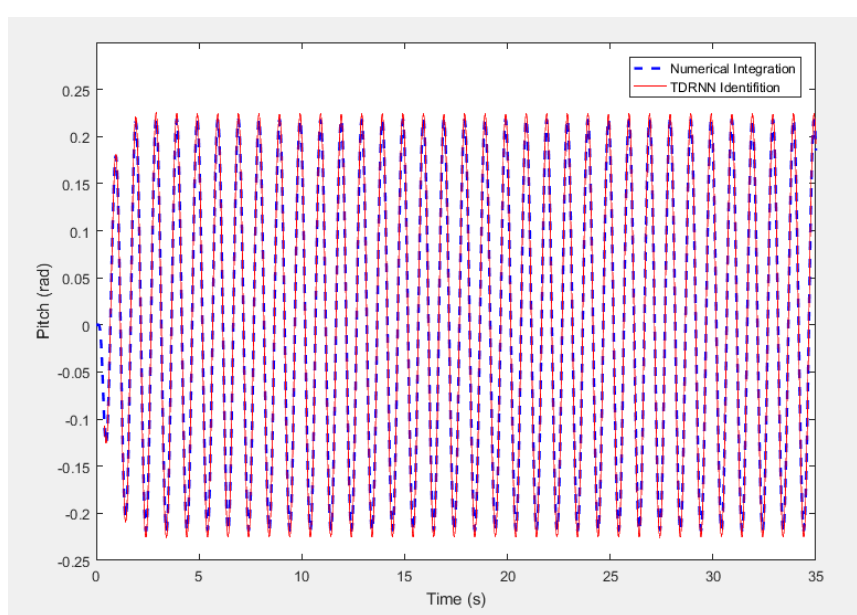
Figure 6. Response of sine input signal.